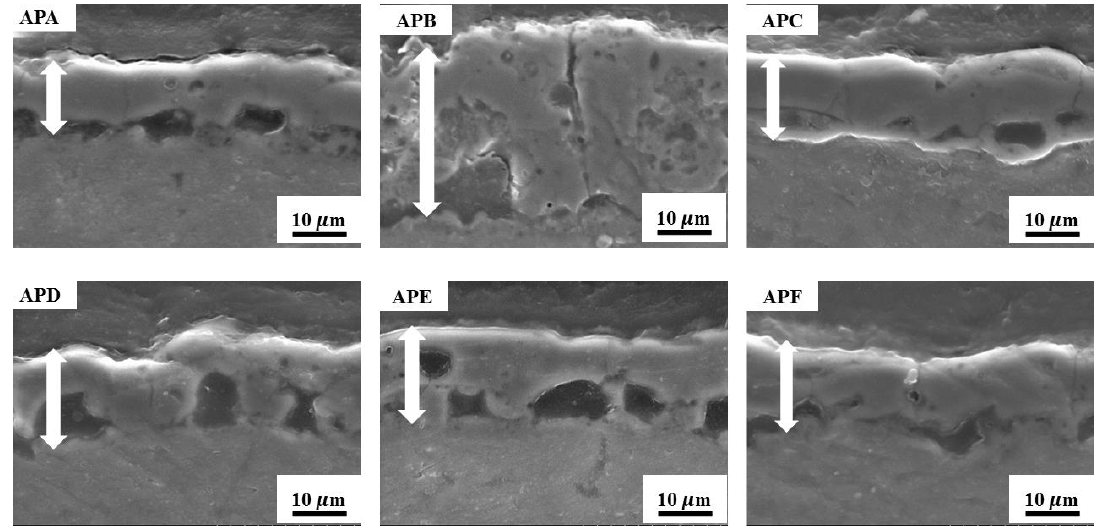
Figure 10. Cross-sectional micrographs of PEO coatings.